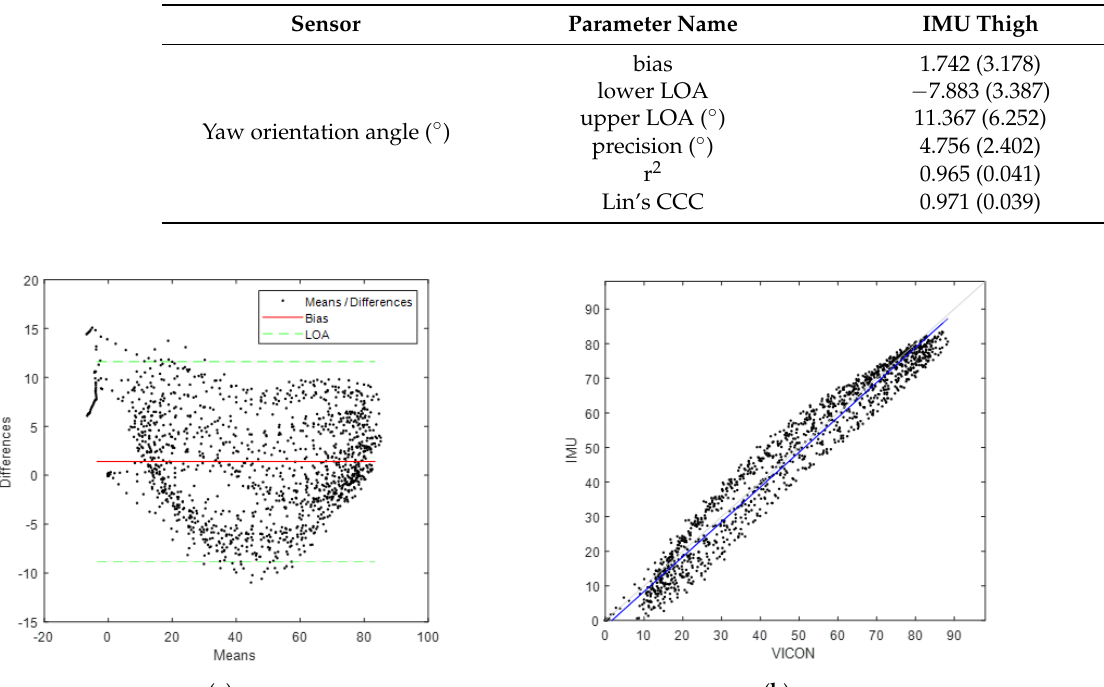
Table 3. Results computed from the Bland–Altman method and Lin’s CCC of segmental validation for yaw angle of the thigh computed with VICON compared to the IMU. All values are averaged between acquisition with standard deviation in parentheses.